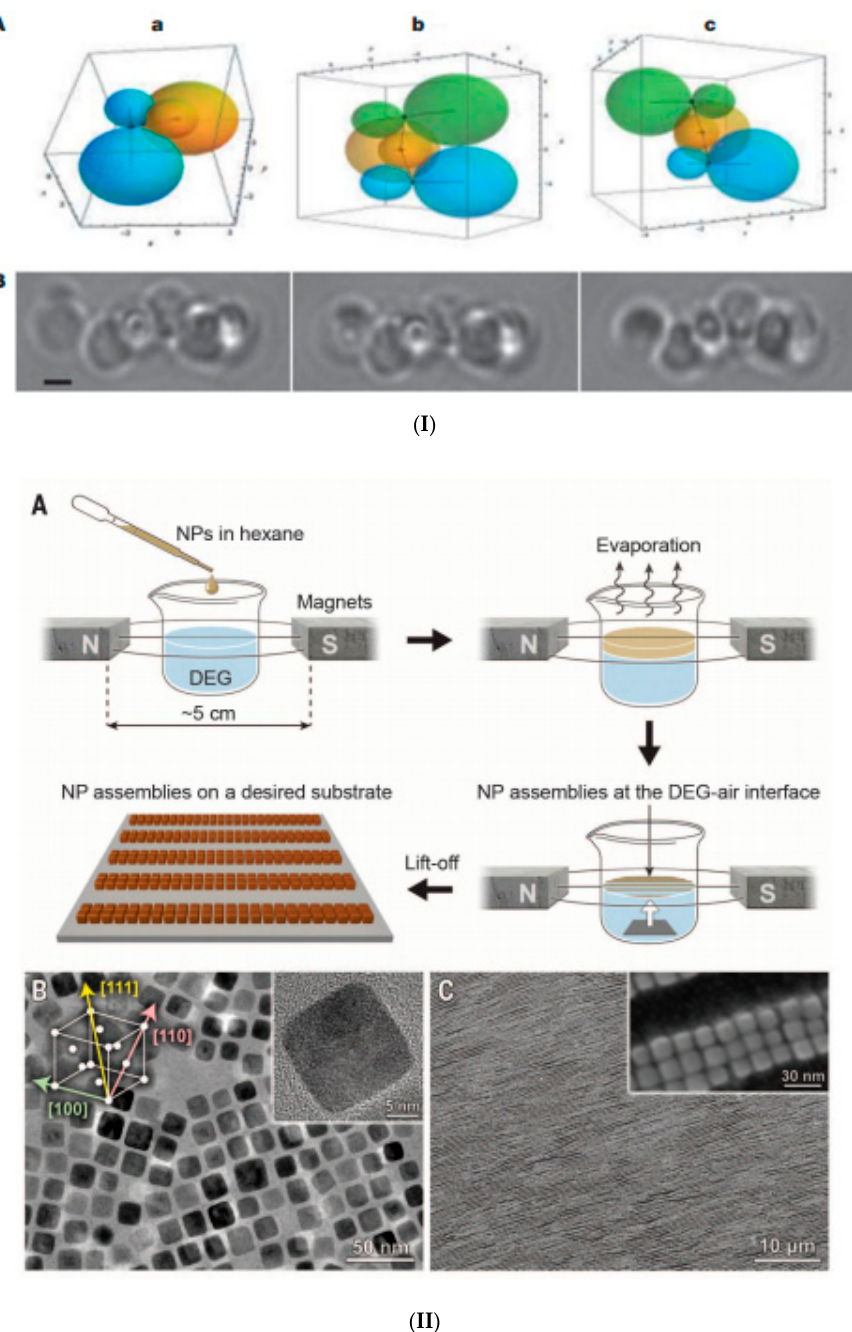
Figure 13. ( I ) Magnetoresponsive dumbbell assembly. ( A ) Schematics showing a pair of dumbbells ( a ) and the two ways in which a third dumbbell could be added to that pair ( b , c ). ( B ) Optical microscopic images showing the kinetic pathway of a dumbbell that diffuses and assembles onto a five-dumbbell helix. Scale bar, 1 mm. (Reprinted by permission from Copyright Clearance Center: Springer Nature, Nature, [208], Copyright 2015). ( II ) Self-assembly of one-dimensional nanocube belts. ( A ) Schematic representation of the experimental setup. ( B ) Low- and high-magnification transmission electron microscopy (TEM) images of the building blocks, ≈ 13-nm Fe 3 O 4 nanocubes. The (111), (110), and (100) crystallographic directions correspond to the easy, intermediate, and hard axes of magnetization, respectively. ( C ) Low- and high-magnification scanning electron microscopy (SEM) images of belts 100 [209]. Reprinted with permission from AAAS).